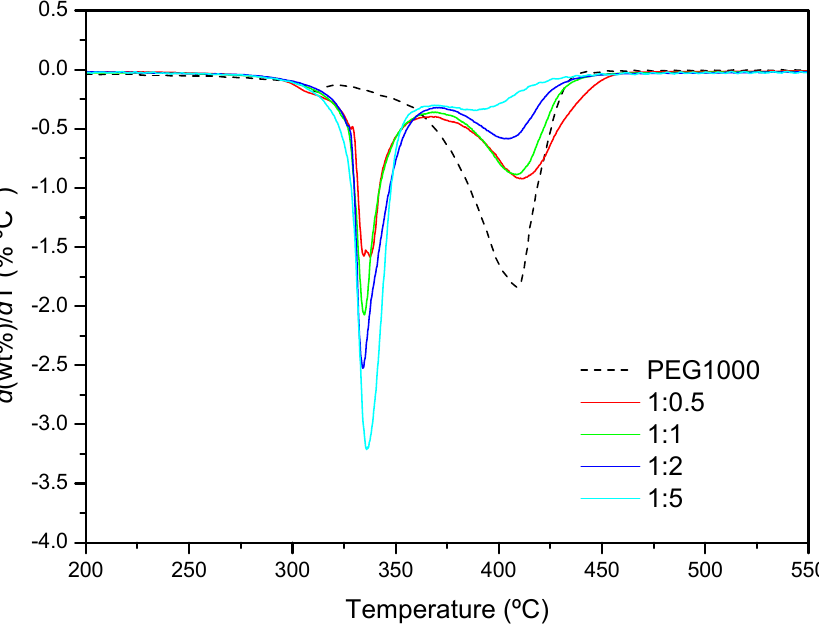
Figure 11. DTG profiles of PEG1000 and the product formed after 24 h at 50 °C (1:0.5, 1:1, 1:2 and 1:5 molar ratios).